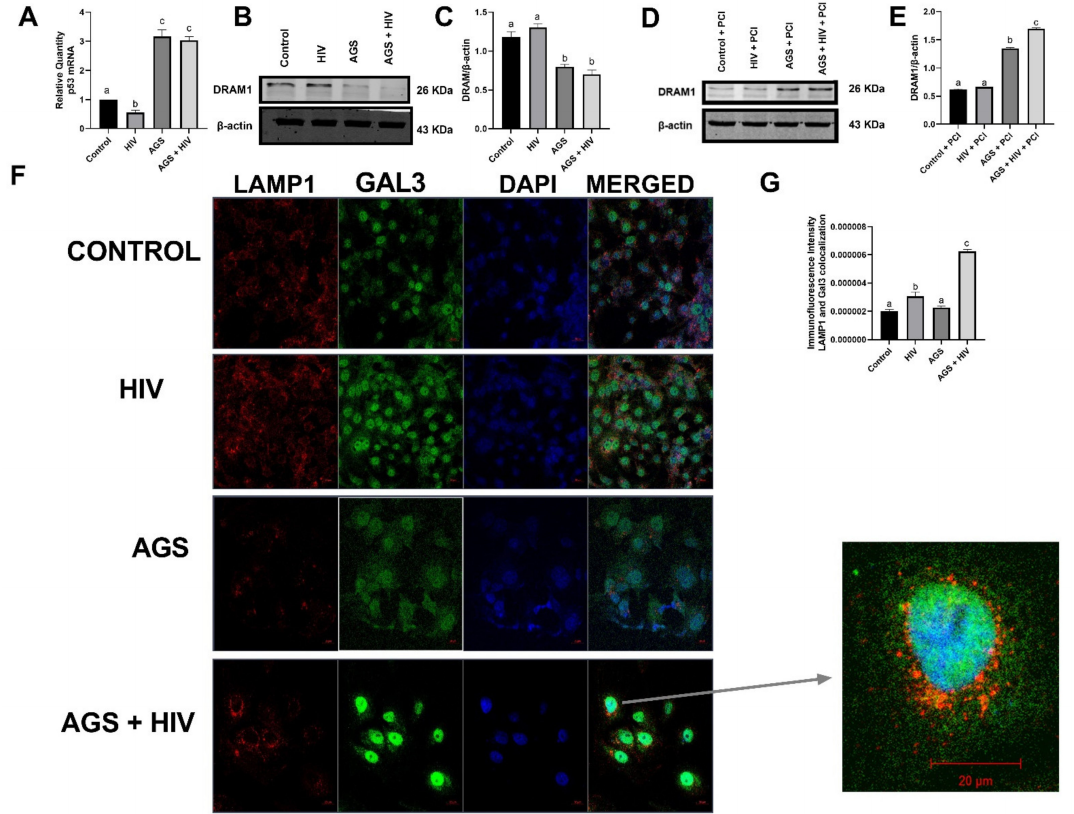
Figure 2. AGS and HIV enhance lysosomal leakage in RLW cells treated as indicated in Materials and Methods. ( A ) p53 mRNA levels were measured by RT-PCR with GAPDH mRNA as the internal standard. ( B , C ) DRAM1 pro- tein expression in the absence of pan-caspase inhibitor (PCI) was detected by immunoblotting. Quantification of protein bands from 3 independent experiments is presented. Equal (20 µ g) amounts of protein were loaded in each lane (as stated in Materials and Methods). β -actin was used as the internal standard. ( D , E ) DRAM1 protein expression in the presence of PCI was detected by immunoblotting. Quantification of protein bands from 3 independent experiments is presented. ( F ) Co-localization of galectin 3 and LAMP1 was measured by immunofluorescence. Proteins were visualized using a 40 × lens LSM 710 confocal microscope. ( G ) Co-localization of galectin 3 and LAMP1 was quantified using NIH Image J. Data are from 3 independent experiments presented as mean ± SEM. Bars marked with the same letter are not significantly different from each other; bars with different letters are significantly different from each other ( p ≤